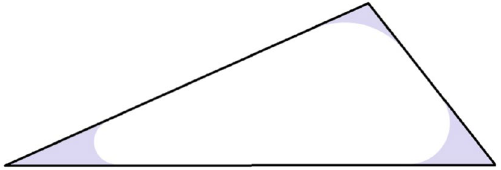
Fig. 1 Element that has been invaded by non-wetting phase during drainage